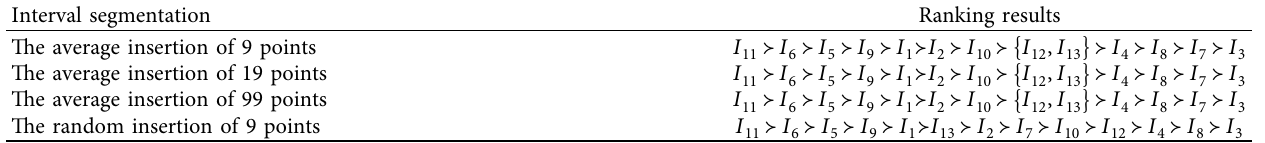
Table 4: Ranking results of implication operators.